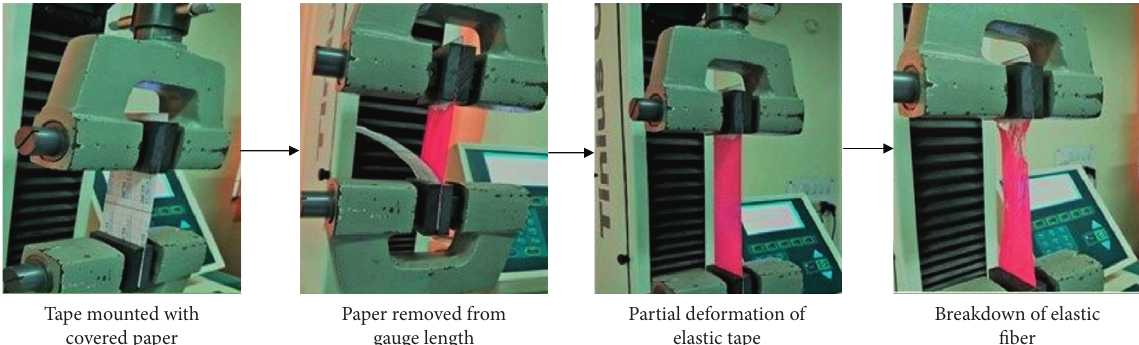
Figure 3: Three steps of sample mounting for a tensile test of tapes. (a) The tape is mounted with covered paper. (b) The paper is removed from gauge length. (c, d)The test is run up to failure.